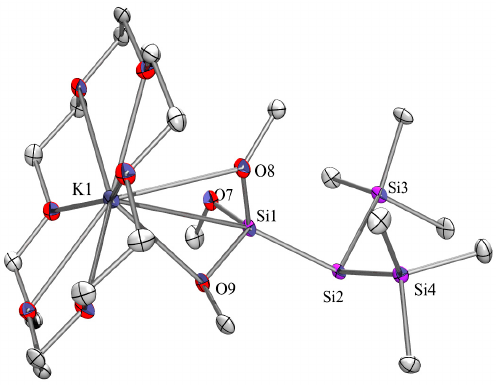
Figure 14. Crystal structure of 16a . Thermal ellipsoids are represented at the 30% level and hydrogen atoms have been omitted for clarity (bond lengths in Å, angles in deg). K(1)-Si(1) 3.5694(19), Si(2)-Si(1) 2.313(2), Si(2)-Si(3) 2.3386(19), Si(2)-Si(4) 2.350(2), Si(3)-C(18) 1.883(5), Si(1)-O(7) 1.658(4), Si(1)-Si(2)-Si(4) 103.97(7), Si(3)-Si(2)-Si(4) 104.33(7), Si(2)-Si(1)-K(1) 158.14(7).